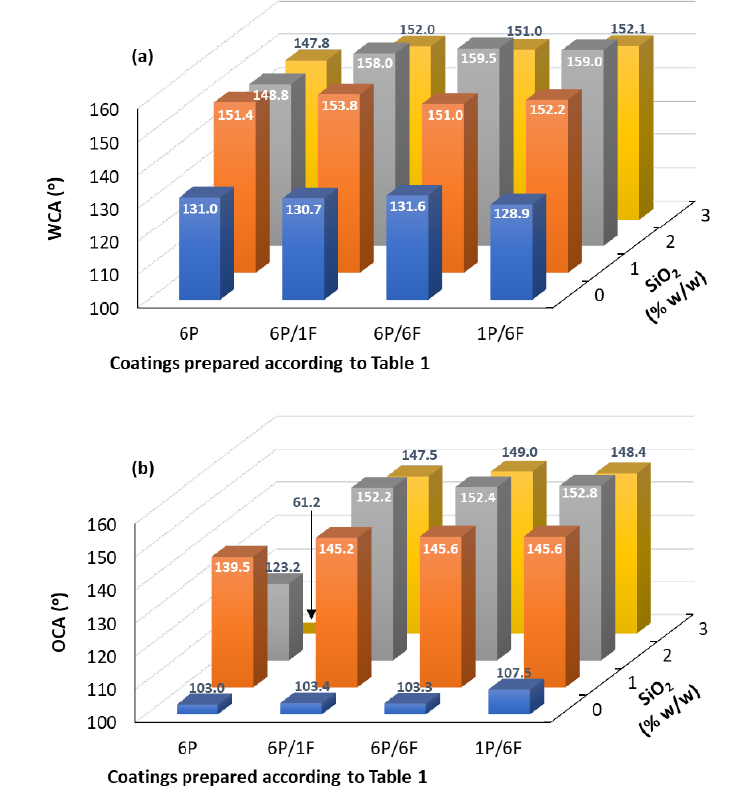
Figure 4. ( a ) WCA and ( b ) OCA on the sixteen coatings which were prepared using different P and F ratios and SiO 2 NP concentrations.